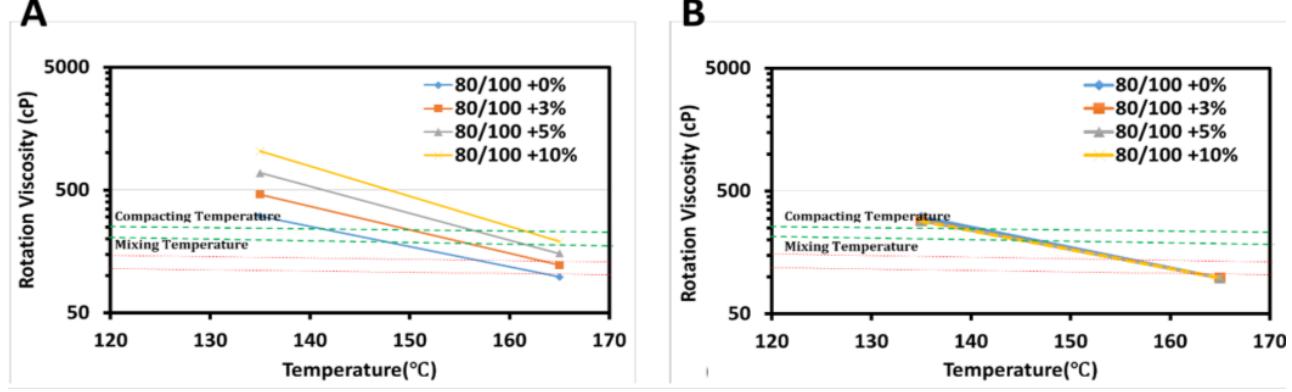
Figure 3. Viscosity-temperature curve for 75 µm PET: ( A ) dry mix mechanism, ( B ) wet mix mecha- nism.